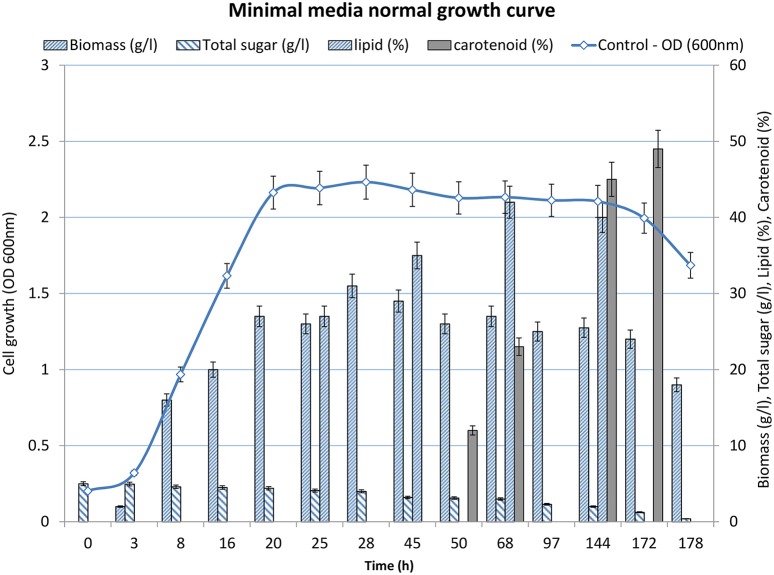
Growth profile of R. toruloides showing increase in OD(600nm) over time with depletion of glucose.